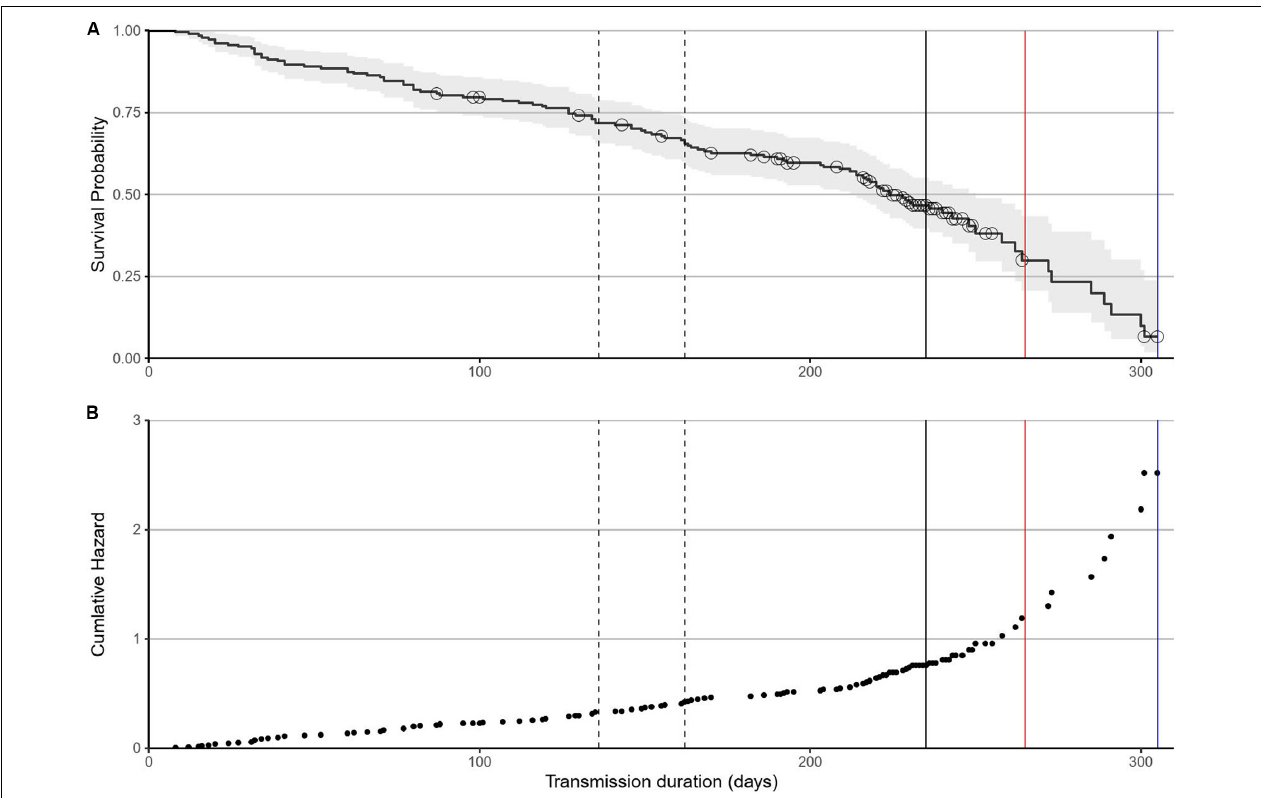
FIGURE 3 | Failure rate determined by a CPH survival model. (A) Tag failure rates for the first 200 days were constant over time, with no association with haul-outs when tags were likely to be damaged. The median male first haul-out was at 136 days with median departure at 162 days (dashed lines). The median female breeding haul-out (solid line) was at 236 days. The range of time adjusted mortality for males (blue line) and females (red line) are plotted. Black circles are censored tracks and grey areas represent 95% confidence intervals. (B) The associated cumulative hazard function remained constant before accelerating after 200 days.